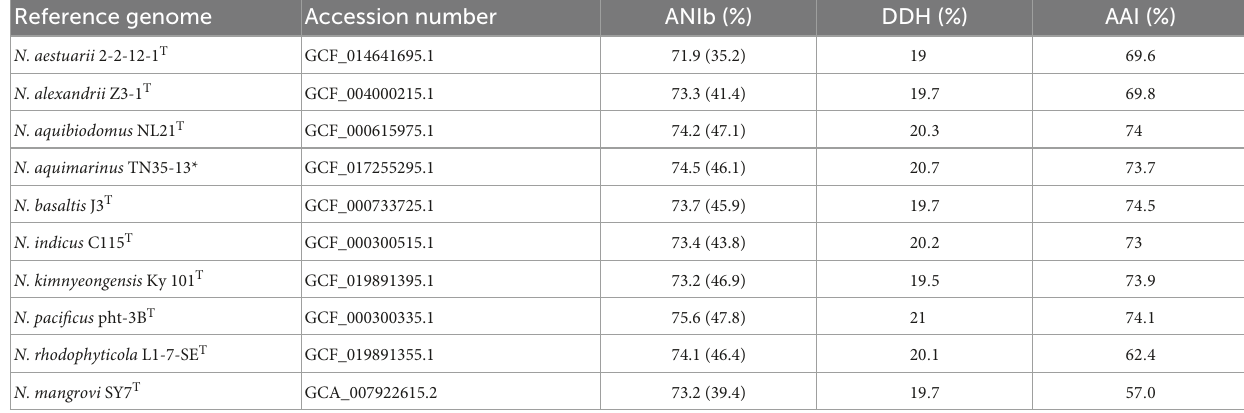
TABLE 1 (i) Average nucleotide identity via BLAST (ANIb) and percentage of aligned sequences in brackets, (ii) in silico DNA-DNA hybridization (DDH) calculation, and (iii) average amino acid identity (AAI) of Nit1536 T against other representatives of the Nitratireductor genus, namely, N. aestuarii 2-2-12-1 T (Ou et al., 2017), N. alexandrii Z3-1 T (Jiang et al., 2020), N. aquibiodomus NL21 T (Labbé et al., 2004), N. aquimarinus TN35-13 (non-type strain), N. basaltis J3 T (Kim et al., 2009), N. indicus C115 T (Lai et al., 2011b, 2012), N. kimnyeongensis Ky 101 T (Kang et al., 2009), N. pacificus pht-3B T (Lai et al., 2011a), N. rhodophyticola L1-7-SE T (Kim et al., 2022), and N. mangrovi SY7 T (Ye et al., 2020).